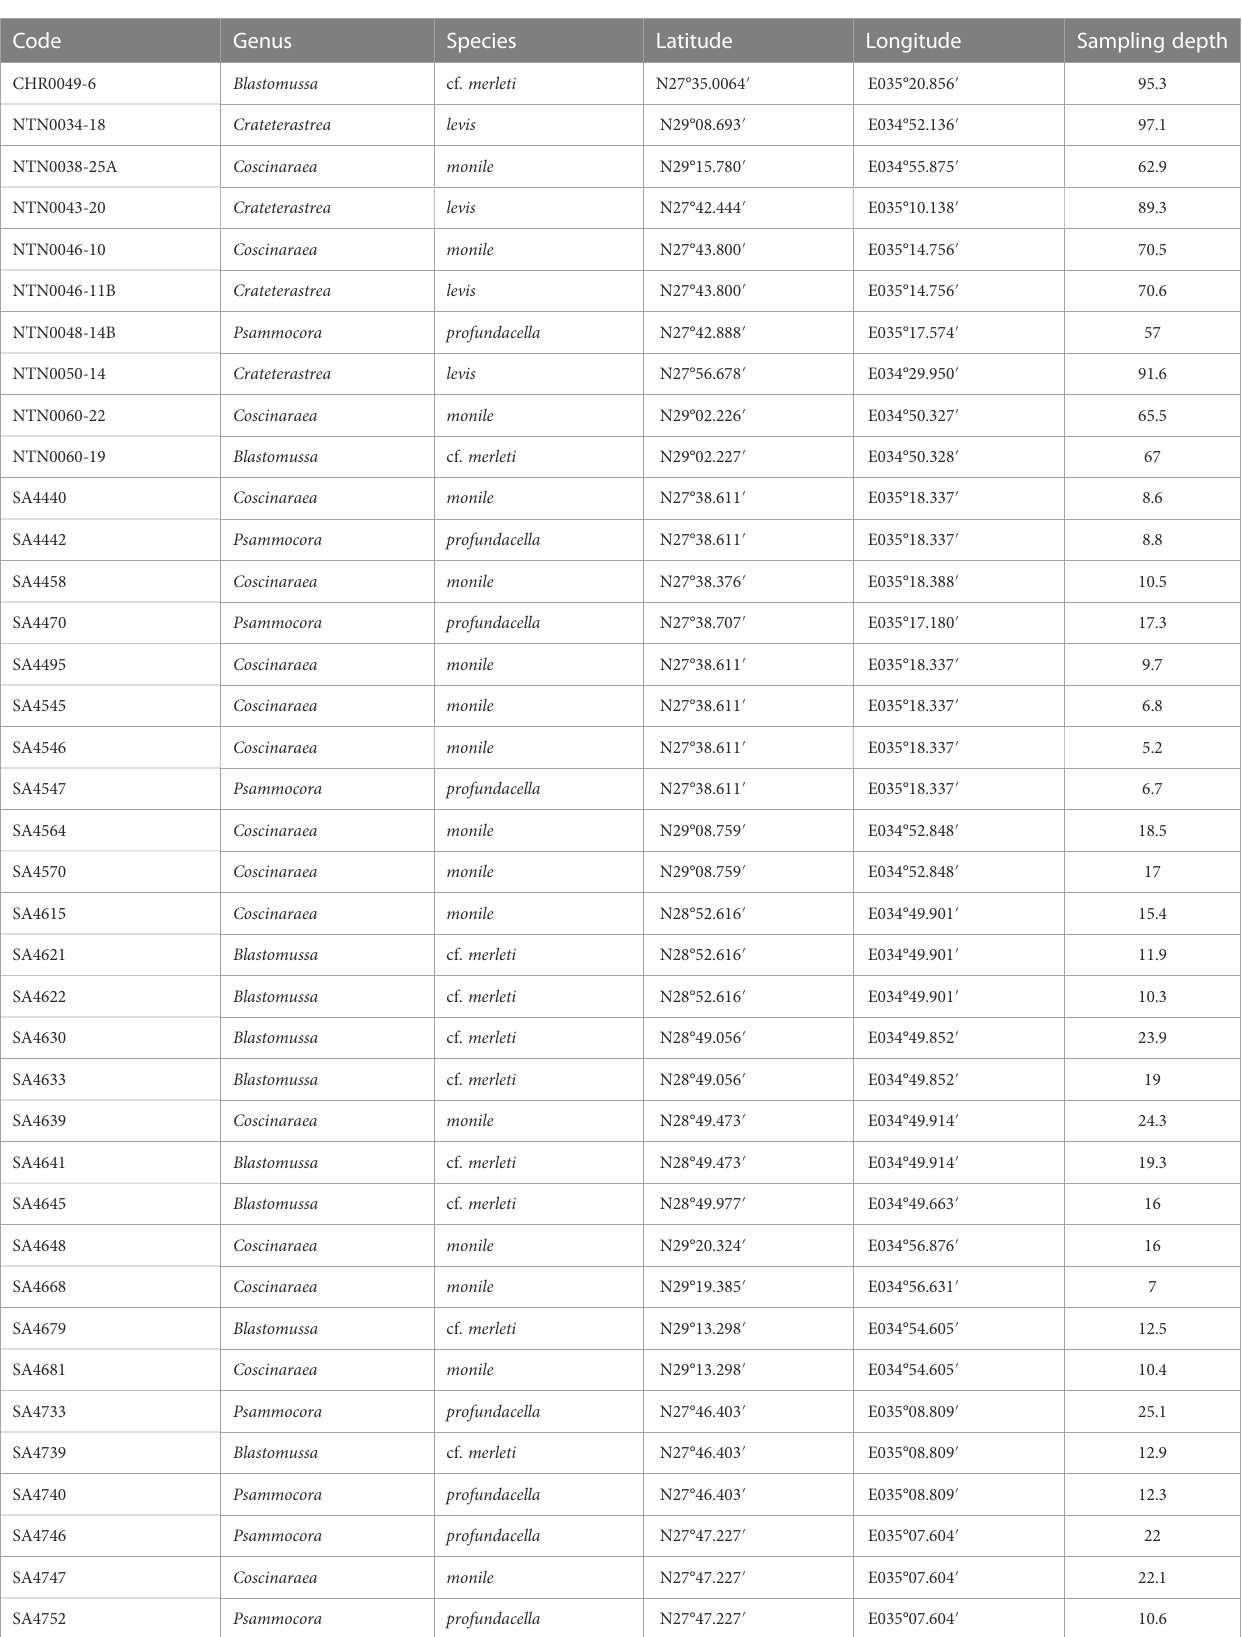
TABLE 1 List of coral specimens collected in the Saudi Arabian Red Sea for the current study, including voucher code, genus and species identi fi cation, and collection